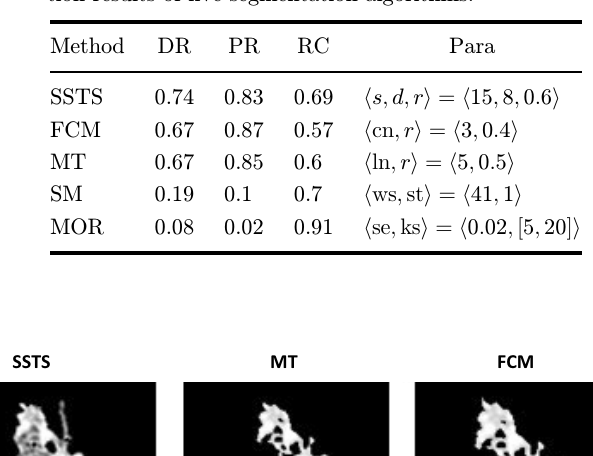
Table 1. De¯nitions of validation metrics.